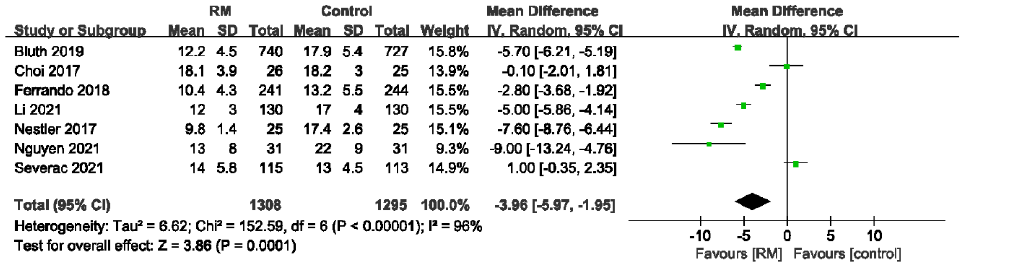
Figure 11. Forest plot for driving pressure between RM and control groups [17 – 19,21,24,25,27].